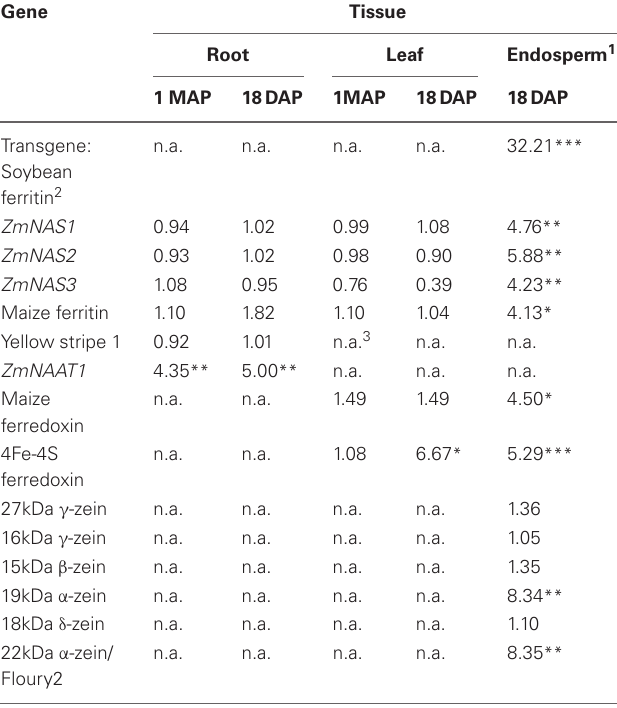
Table 2 | Transcript ratios of transgene PCR positive plants relative to PCR negative plants averaged across four transformation